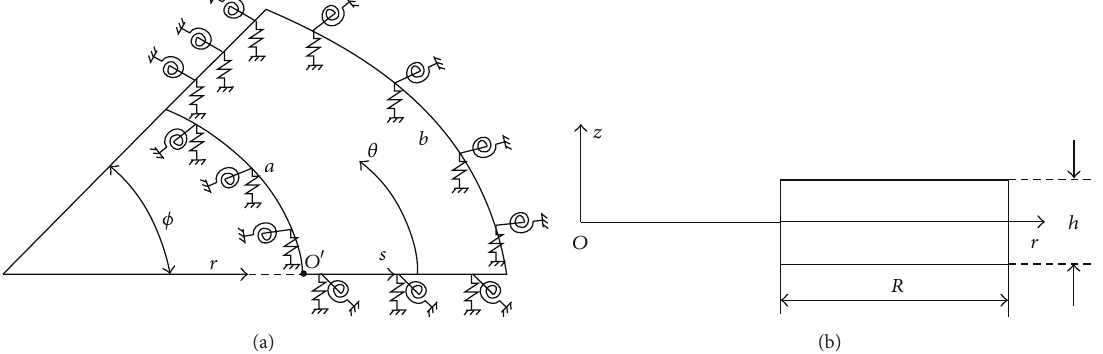
Figure 1: Geometry and dimensions of an annular sector plate. (a) Annular sector plate. (b) Cross section of the annular sector plate.